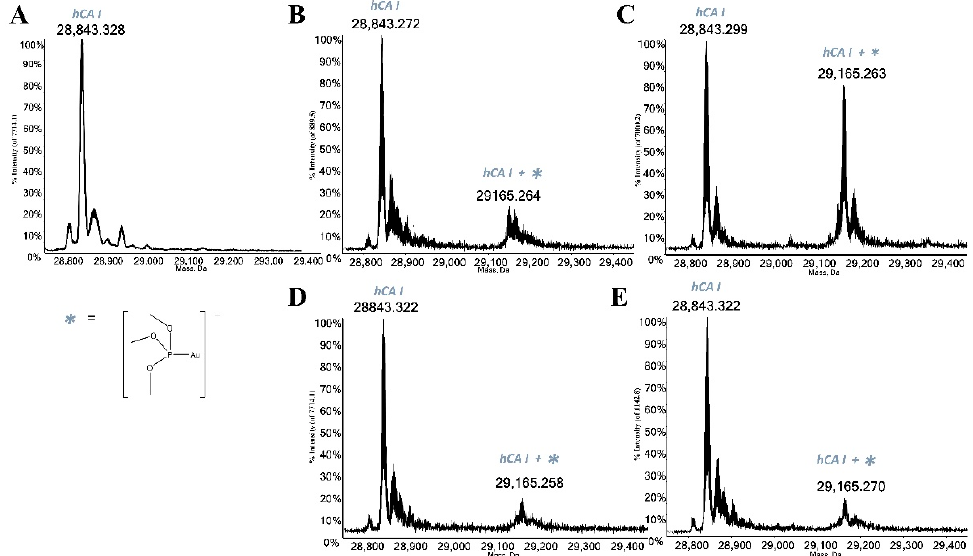
Figure 4. ( A ) Deconvoluted ESI-MS mass spectra of human carbonic anhydrase I (hCA I) 10 − 6 M in 20 mM ammonium acetate solution at pH 6.8 and incubated at 37 °C for 24 h with ( B ) AuP(OCH 3 ) 3 Cl, ( C ) AuP(OCH 3 ) 3 Br, ( D ) AuP(OCH 3 ) 3 I, ( E ) AuP(OCH 3 ) 3 SAtg solution in a 1:1 protein-to-gold ratio.